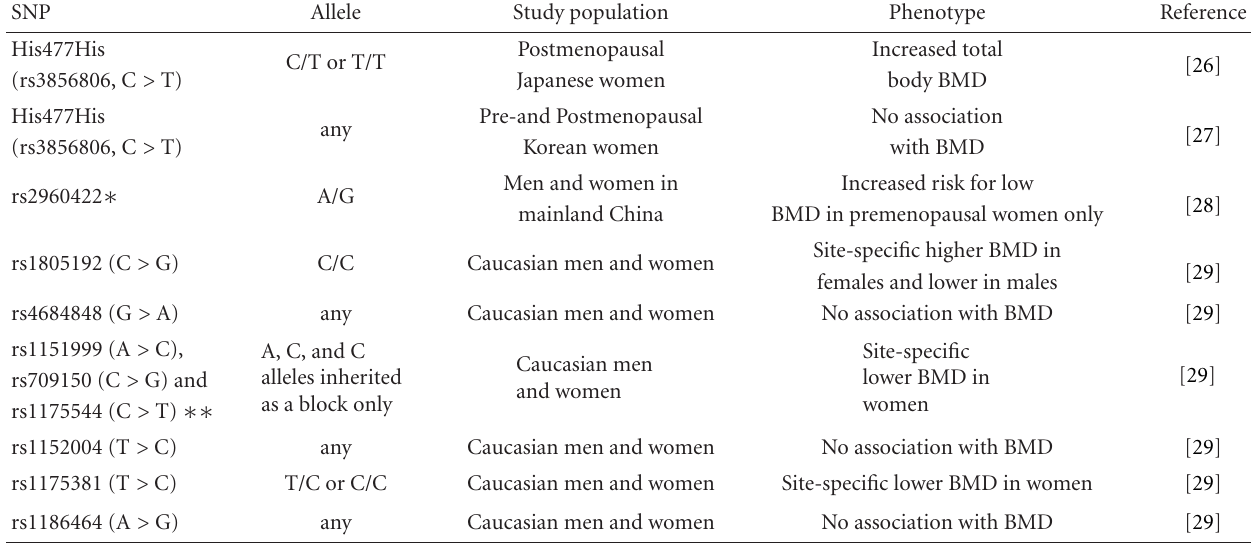
Table 1: A summary of the SNP alleles and associated bone phenotypes as studied to date in humans. The alleles are given in parenthesis after the SNP number with the major allele in the study population listed first. For SNP rs2960422 ( ∗ ) no allele frequency in this population was reported by the authors. SNPs rs11512999, rs709150, and rs1175544 ( ∗∗ ) showed no association with either BMD or BUA when analyzed separately, but an association with BMD was found for the haplotype of rs11512999 (A), rs709150 (C), and rs1175544 (C) in women. SNP